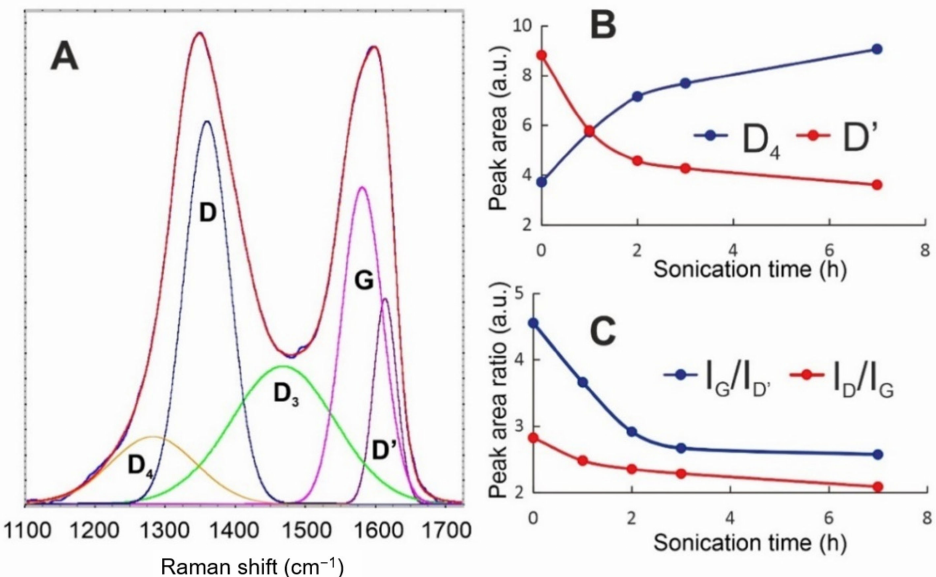
Figure 3. Raman spectroscopic analyses of the size reduction process: ( A ) deconvoluted spectrum of 0n-GO (showing the fitted model); ( B ) the intensity of D 4 and D’ changes during the process; ( C ) effect of the sonication time on the I G /I D’ and I D /I G